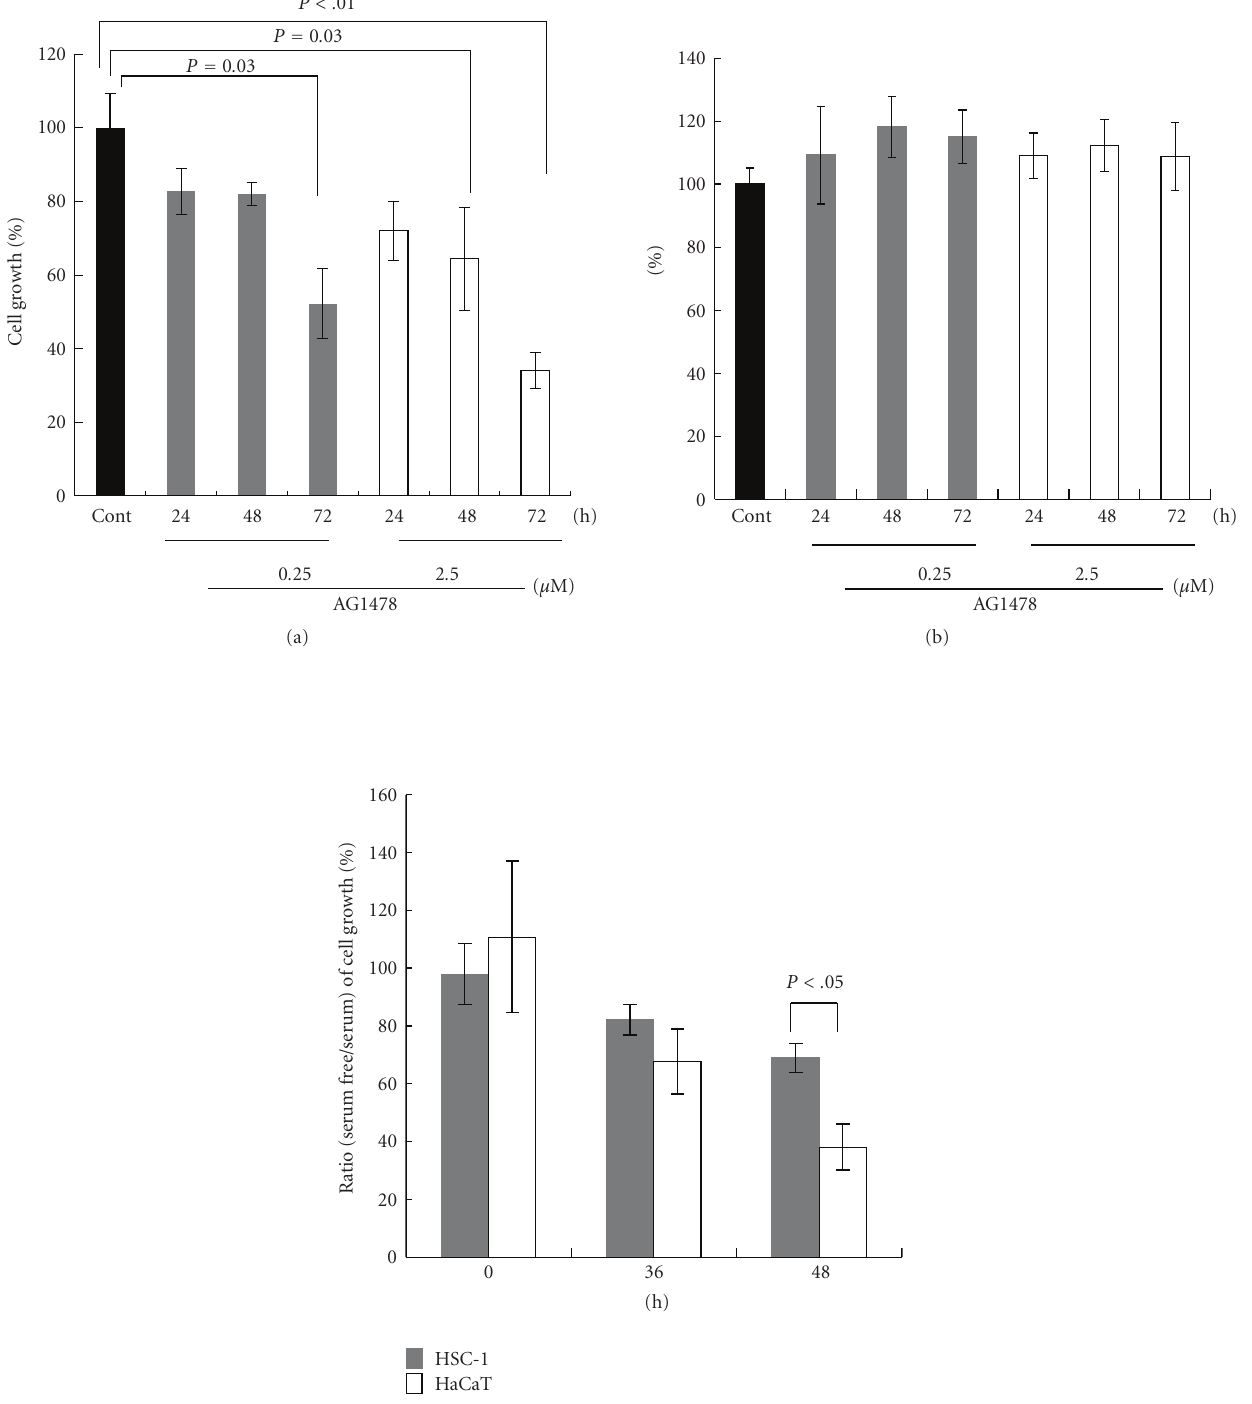
Figure 5: E ff ect of AG1478 on proliferation of HSC-1 cells and HEKs. After HSC-1 cells or HEKs were incubated with AG1478 (0.25 or 2.5 μ M) for indicated periods, cell proliferation was analyzed using the MTS assay ((a), (b)). Cell growth of HSC-1 cells (a) or HEKs (b) was expressed as a percentage of that in untreated cells at each indicated time point up to 72 hours. HSC-1 or HaCaT cells were seeded in medium with 10% fetal calf serum and were cultured for 24 hours. The medium was then changed to serum-free medium or medium with 10% fetal calf serum. The growth of HSC-1 and HaCaT cells was monitored using the MTS assay at 0 hour, 36 hours, and 48 hours after the change of medium and was expressed as the percent ratio (serum-free/serum) (c). Data are mean ± SD of at least three experiments. P < . 05 when compared with each